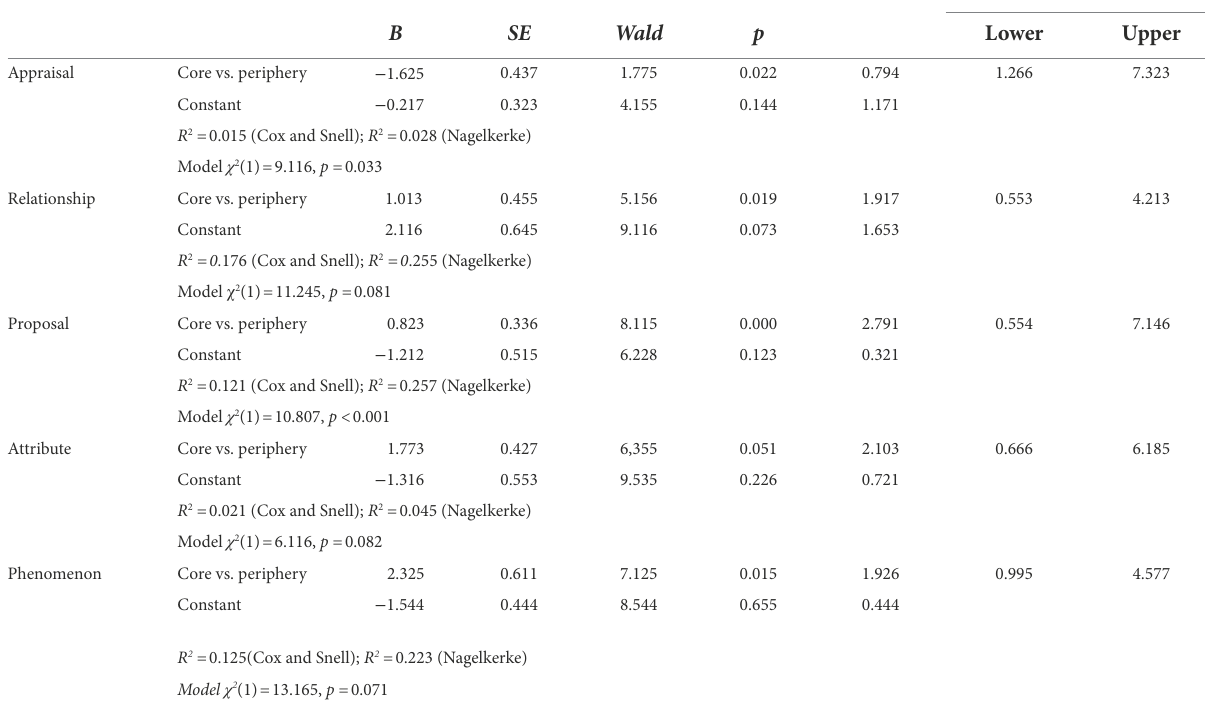
TABLE 4 Results of binary logistic regressions on the frame element of trigger. Outcome Predictor